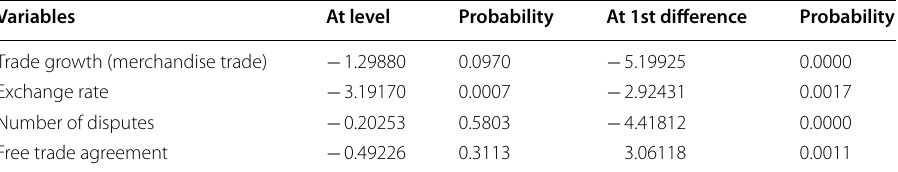
Table 1 Summary of panel unit root test using the Im, Pesaran, and